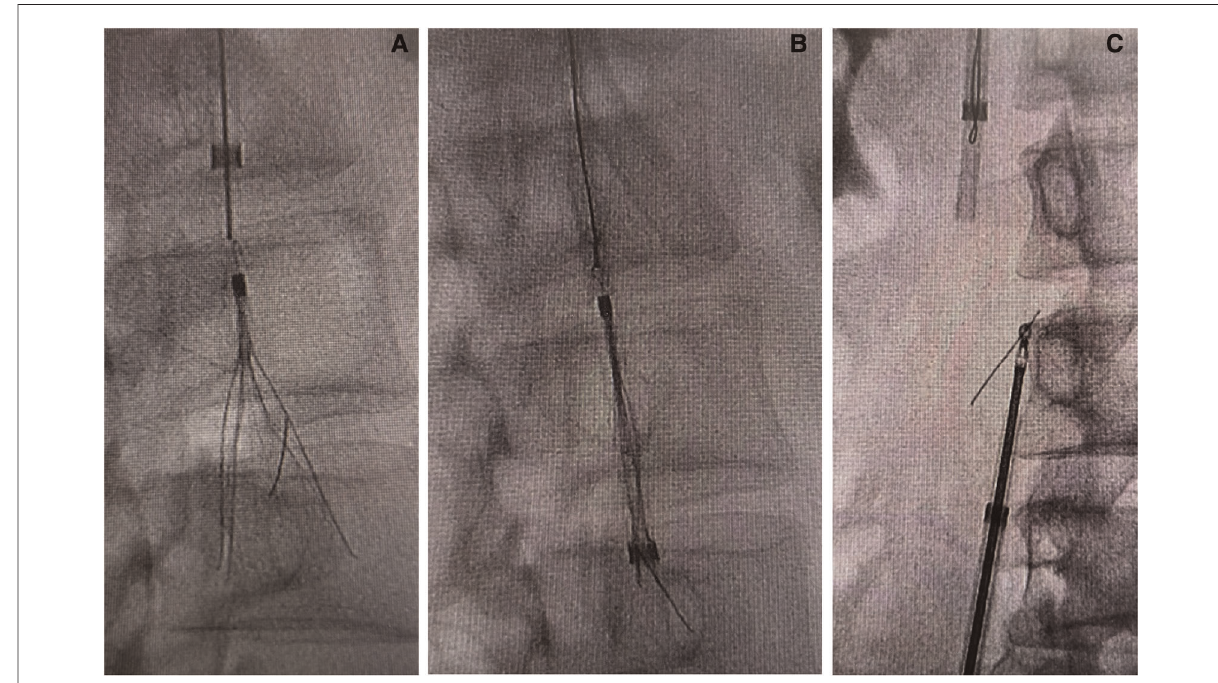
FIGURE 2 ( A ) Cutting the proliferative tissue surrounding the retraction hook and bringing the hook back into the cavity. ( B ) The fi lter was captured by the snare, but one broken pedicle remained in the inferior vena cava. ( C ) Successful capture of the fractured pedicle using biopsy